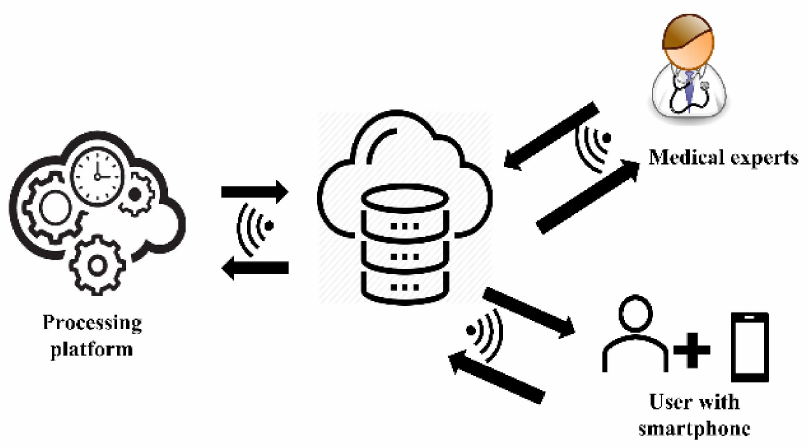
Figure 4. Framework for a connected cataract screening system using